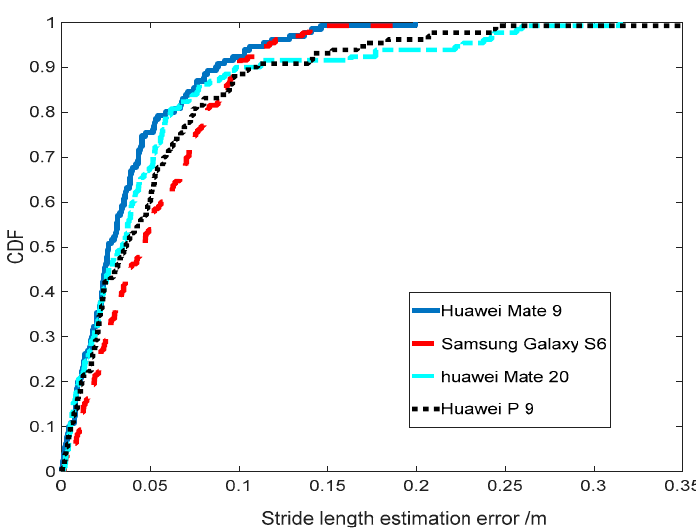
Figure 15. Robustness among different devises.